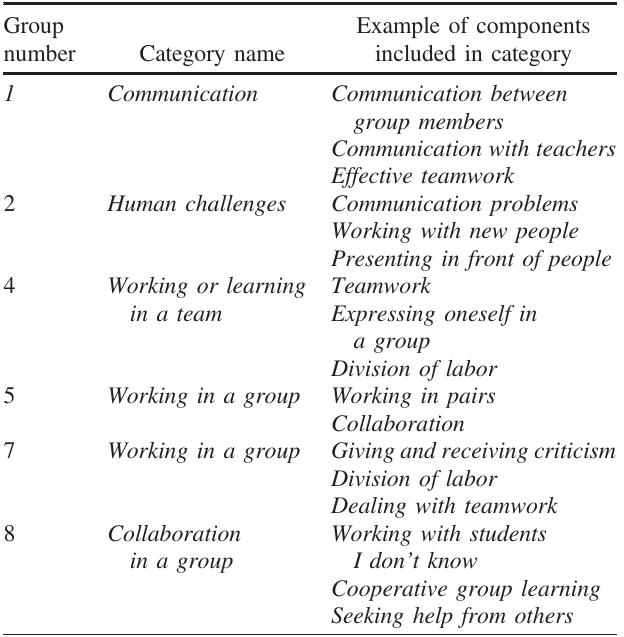
TABLE IV. Student categories corresponding to the top-down category “ teamwork ” and examples for components included in